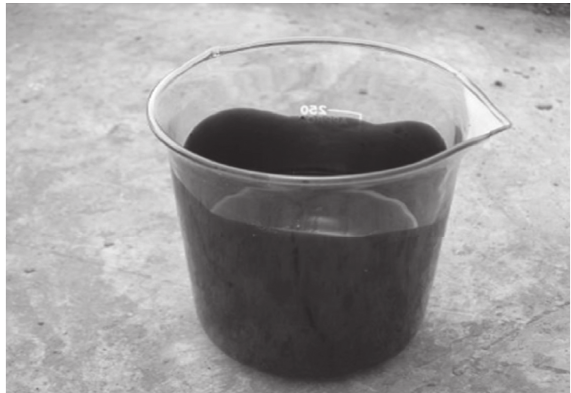
Figure 9: Plant asphalt